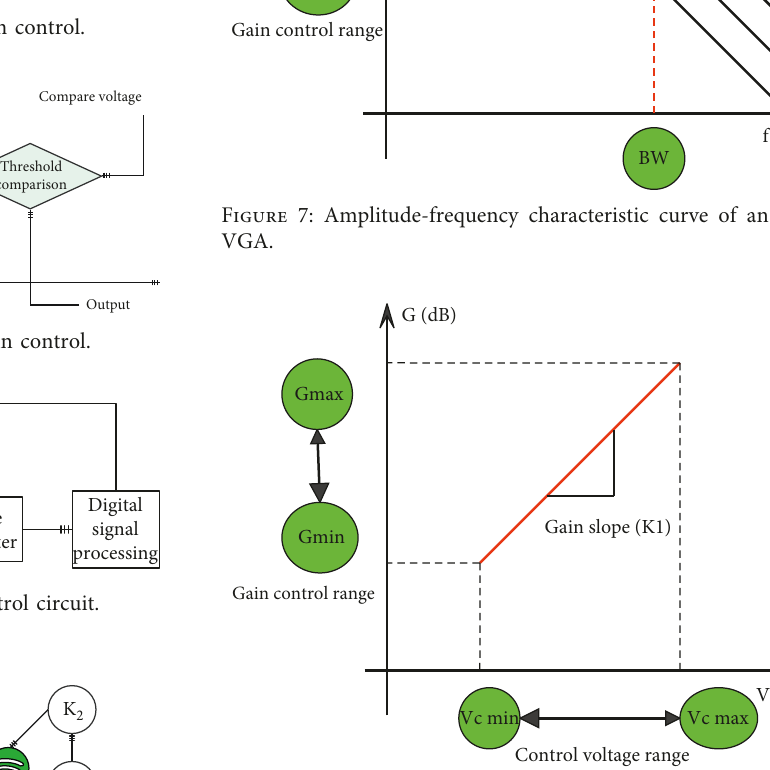
Figure 8: Gain control range and control characteristics of an ideal VGA.